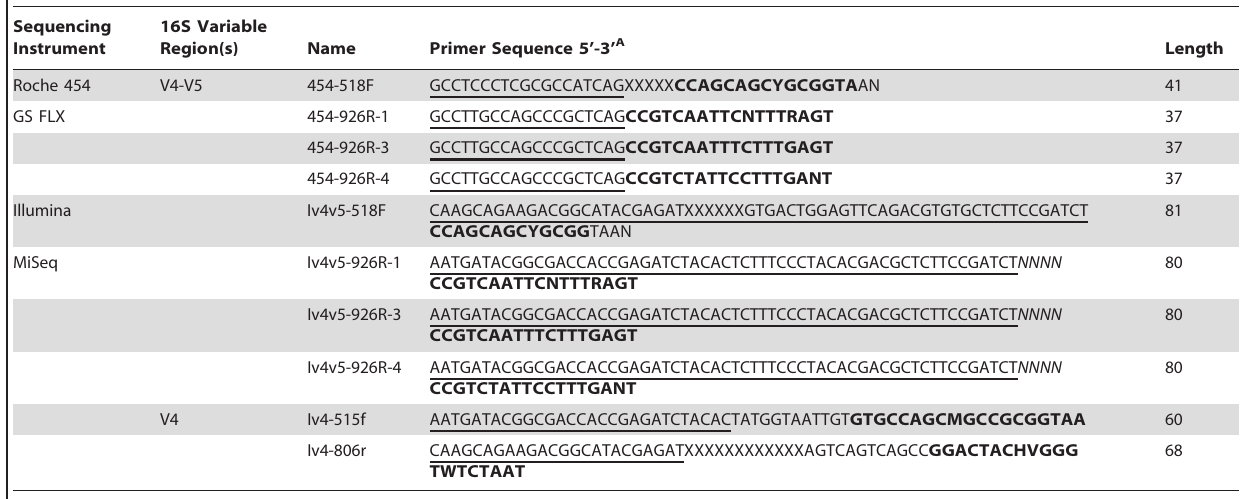
Table 1. Library construction primer sequences.